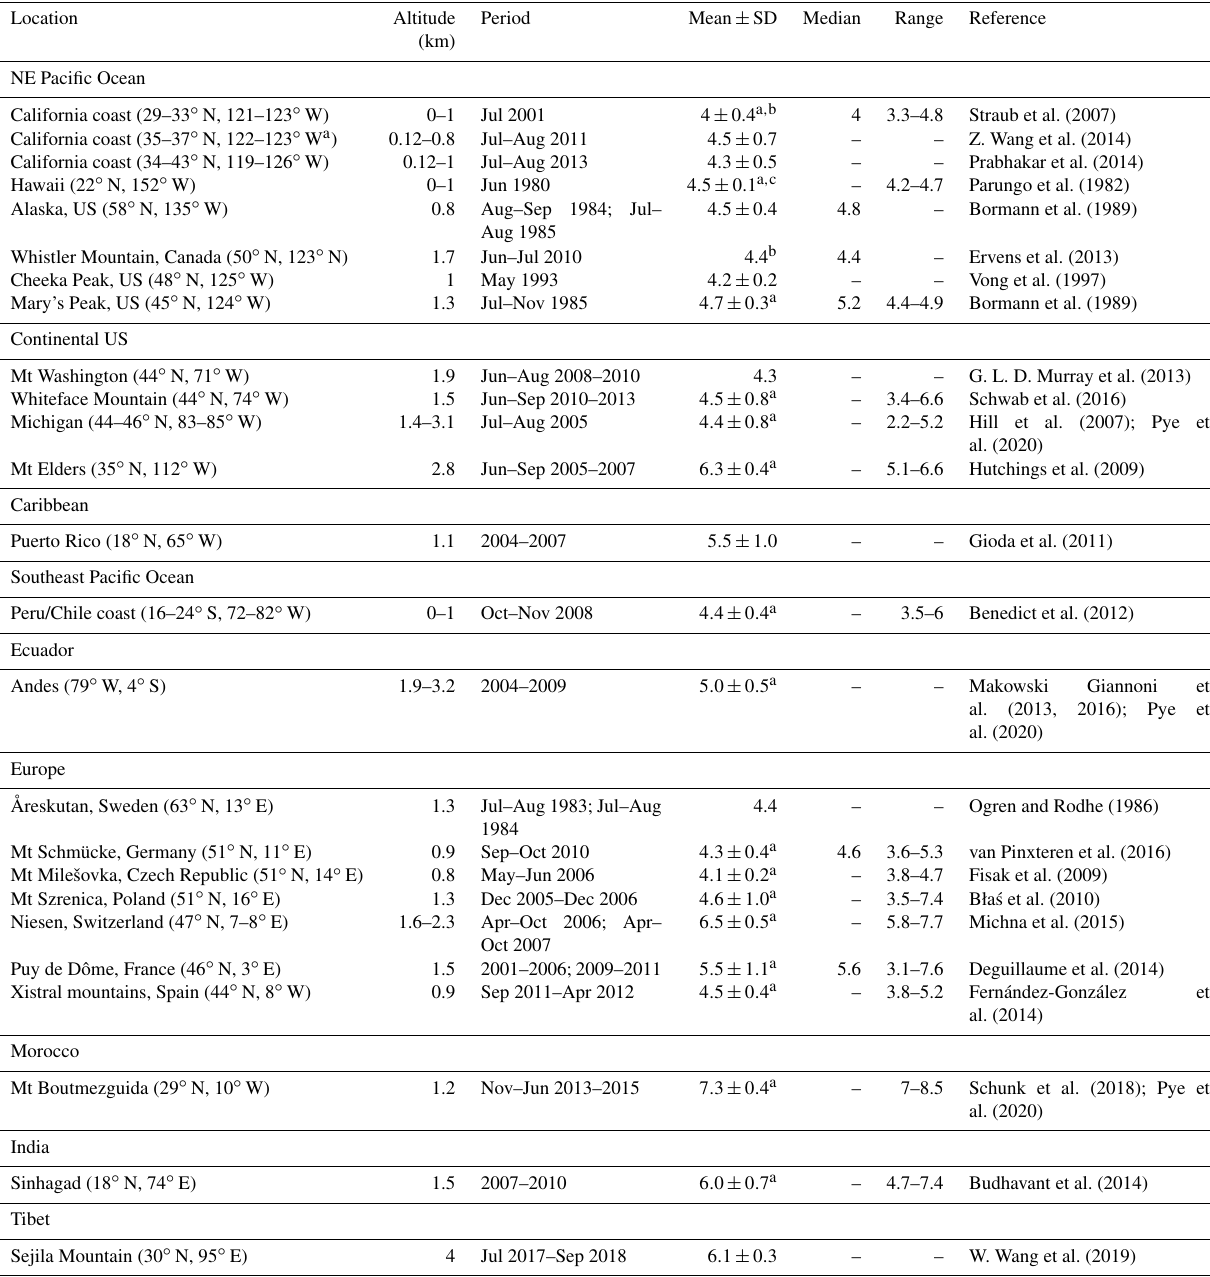
Table A1. Cloud water pH observations grouped by region and listed from west to east and north to south.